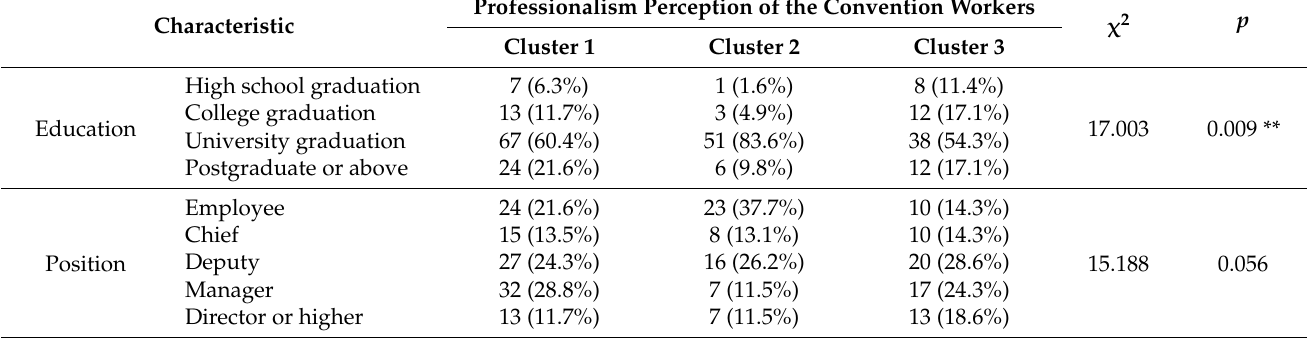
Table 9. Results of Cross Tabulation of Professionalism Perception Segmentation and Demo- graphic